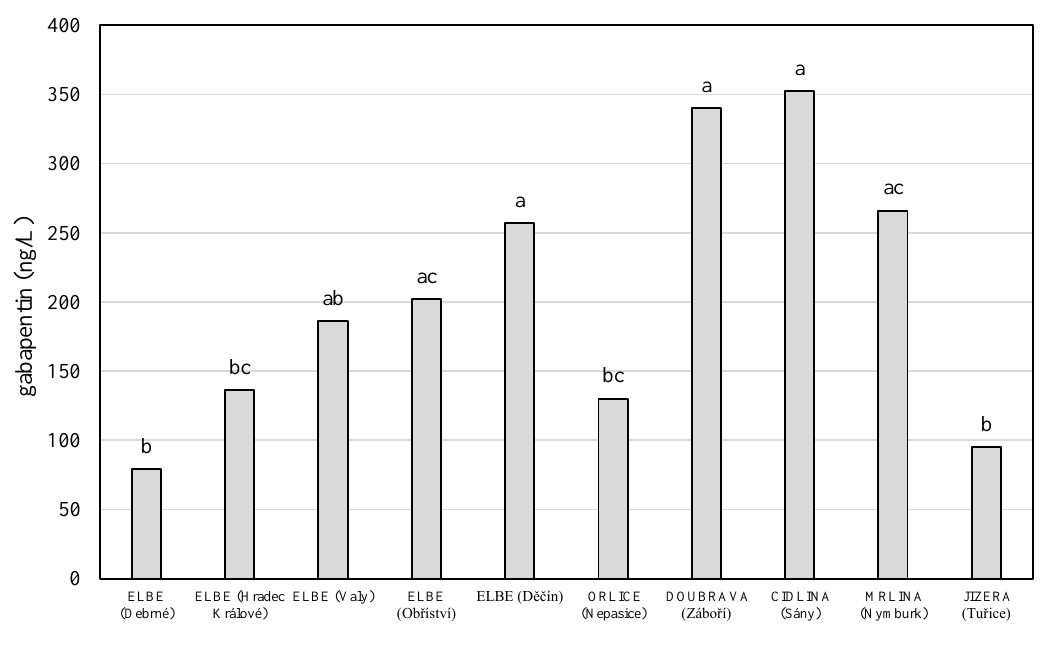
Figure 8. Median values of gabapentin concentration at the sampled locations during the year 2021. Significant differences among localities are indicated by different alphabetical superscripts ( p < 0.05).